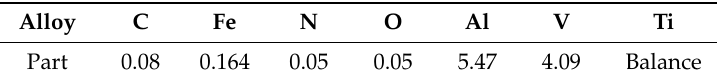
Table 1. Composition of the machined alloy (wt.%).